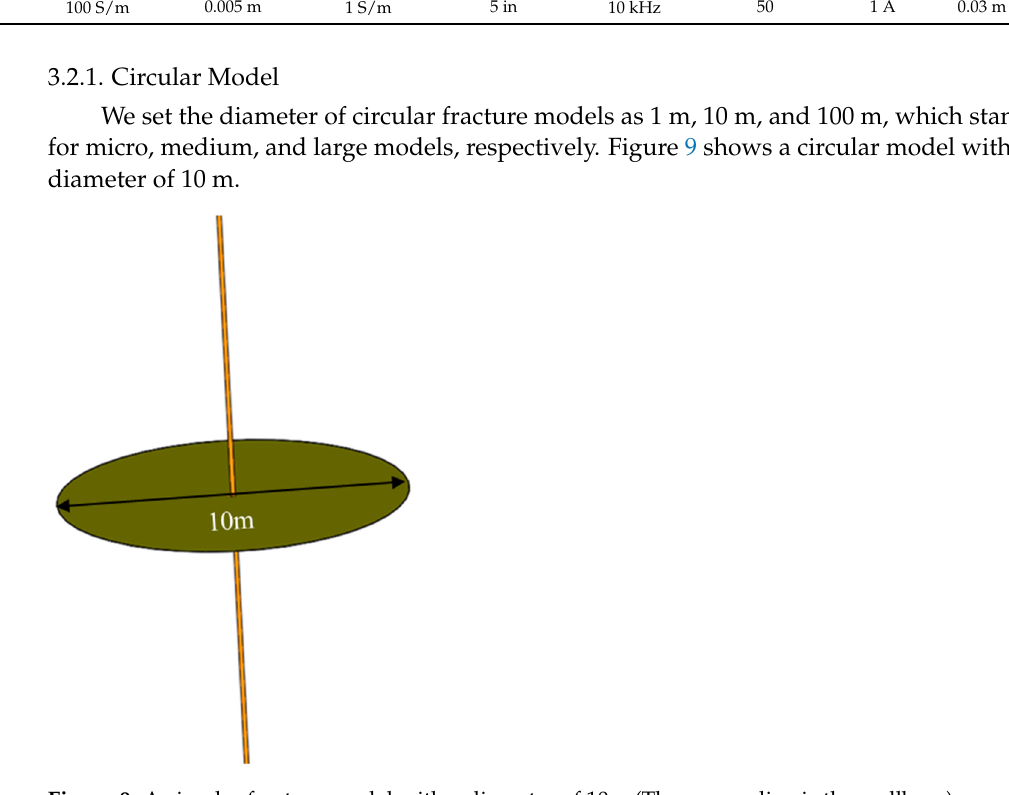
Figure 9. A circular fracture model with a diameter of 10m (The orange line is the wellbore).